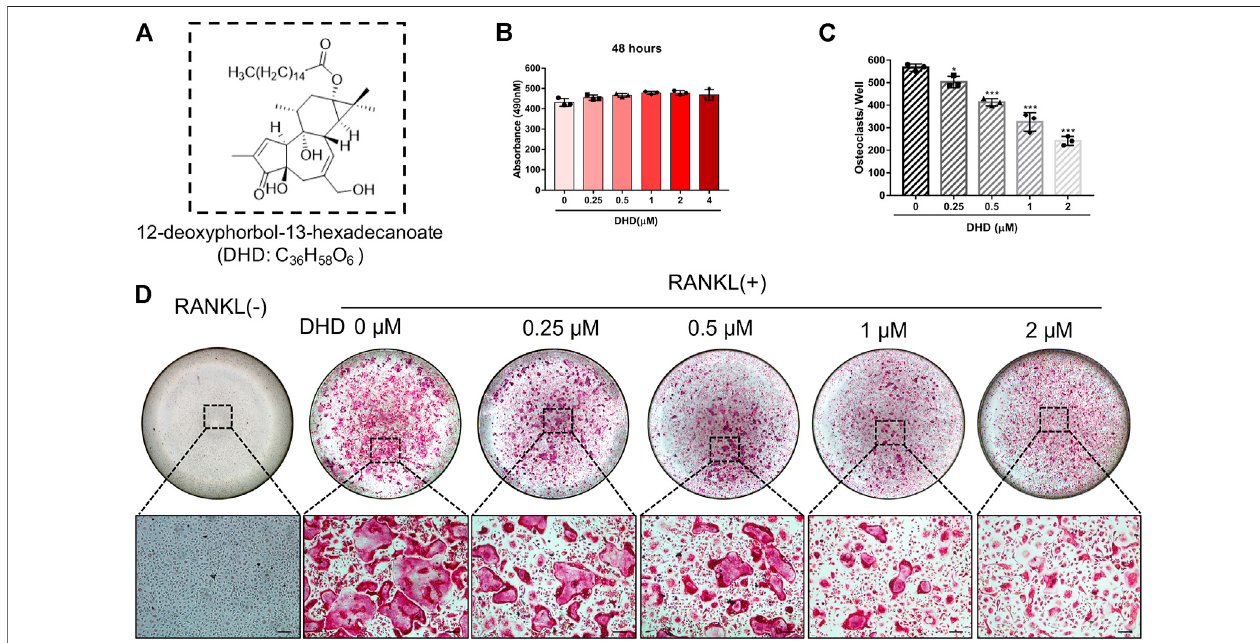
FIGURE 1 | DHD abrogates RANKL-induced osteoclastogenesis in a dose-dependent manner. (A) Chemical structure of DHD. (B) The effects of the different concentrations of DHD (0, 0.25, 0.5, 1, 2, and 4 μ M) on BMMs for 48 h were measured by an MTS assay. (C) The number of osteoclasts per well was quantitatively analyzed. Cells with TRAcP + and multinucleated ( > 3 nuclei) were identi fi ed as osteoclasts. (D) Representative images of TRAcP staining after treatment with DHD at increasing concentrations (scale bar = 200 μ m). Data were presented as means ± SD; p p < 0.05, and ppp p < 0.001 relative to RANKL-induced